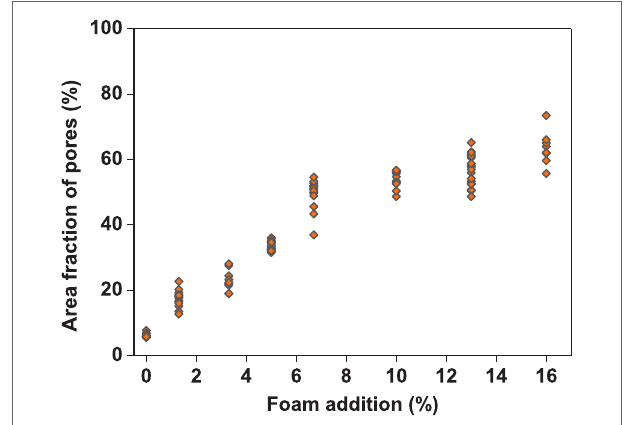
FigUre 5 | area fraction of pores in gFcs .